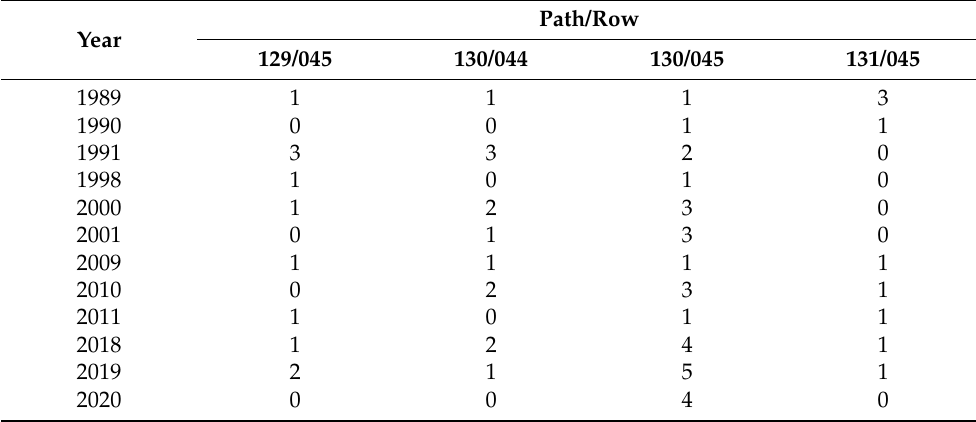
Table 1. The number of Landsat images (Path/Row) used in this study.